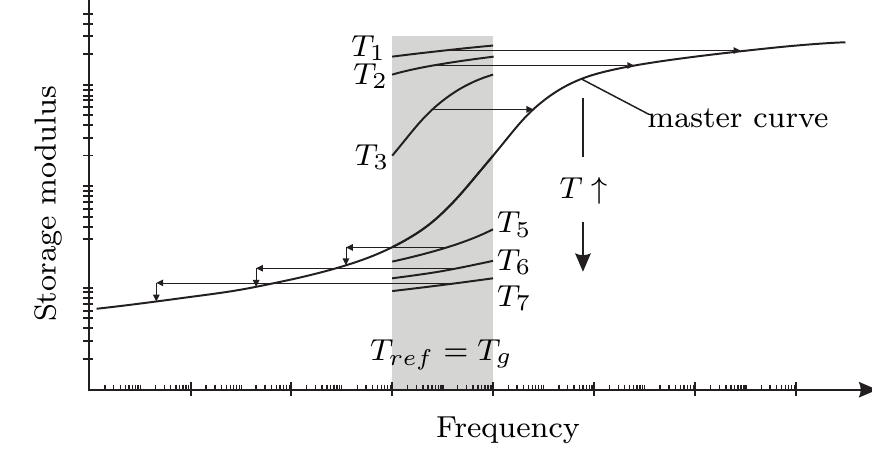
Figure 3. Application of the